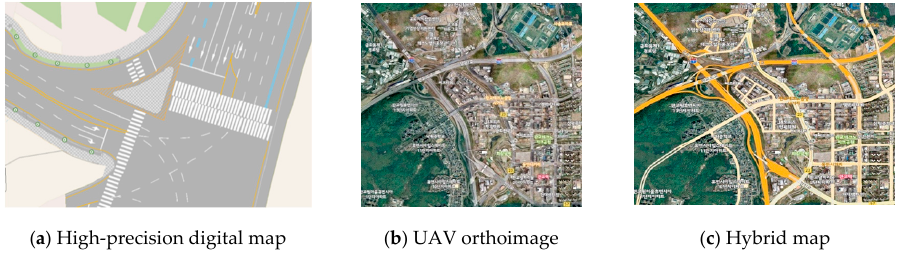
Figure 6. Final outcome of three types of base maps.